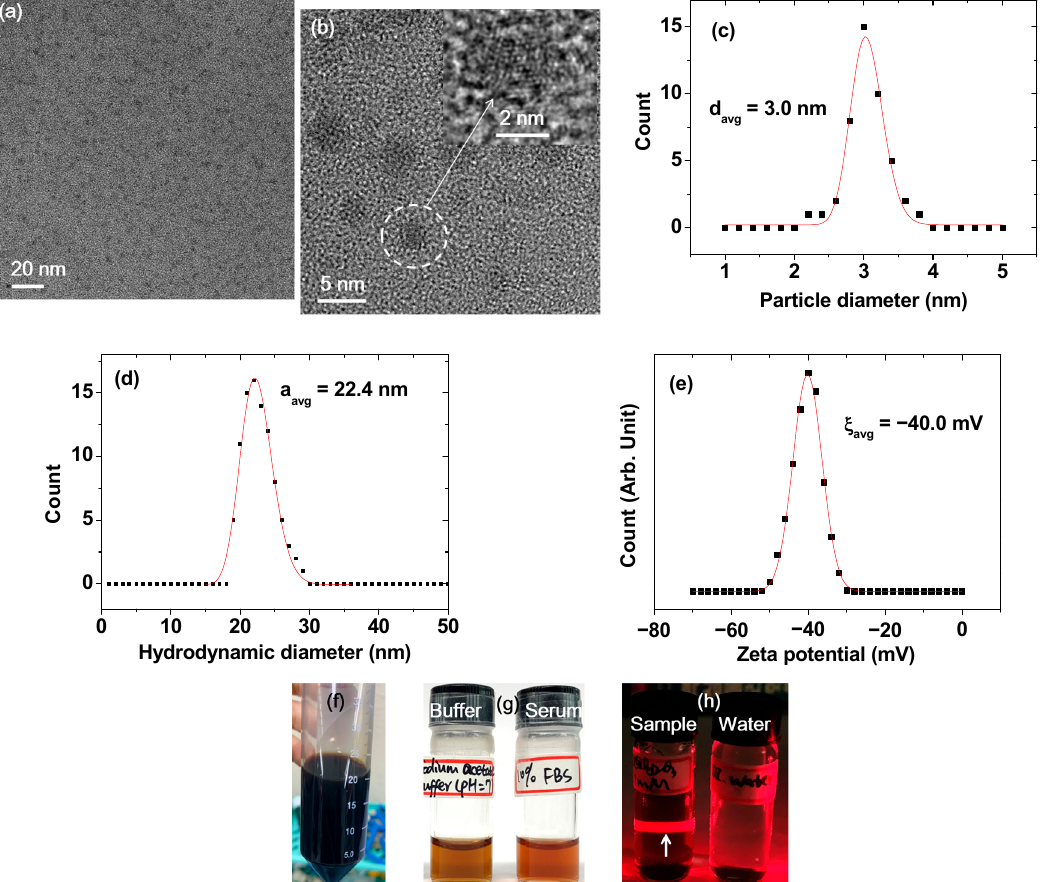
Figure 1. Various characterization results of the DYO@C nanoparticles: ( a ) TEM image at the 20-nm scale; ( b ) HRTEM image at the 5-nm scale (inset is a magnified image of the dotted circle at the 2-nm scale); ( c ) plot of particle diameter distribution and a log-normal function fit to obtain d avg ; ( d ) plot of hydrodynamic diameter distribution and a log-normal function fit to obtain a avg ; ( e ) plot of zeta potential and a Gaussian function fit to obtain ξ avg ; ( f ) concentrated aqueous solution sample (18 mM Dy); ( g ) photographs of the nanoparticle suspension samples in a 10% FBS in RPMI1640 medium (right) and a sodium acetate buffer (pH = 7) solution (left; 1.8 mM Dy) showing no nanoparticle precipitation for 10 days; and ( h ) Tyndall effect showing laser light scattering (indicated with an arrow) due to nanoparticle suspension (left) and the reference triple-distilled water, which did not show laser light scattering (right).